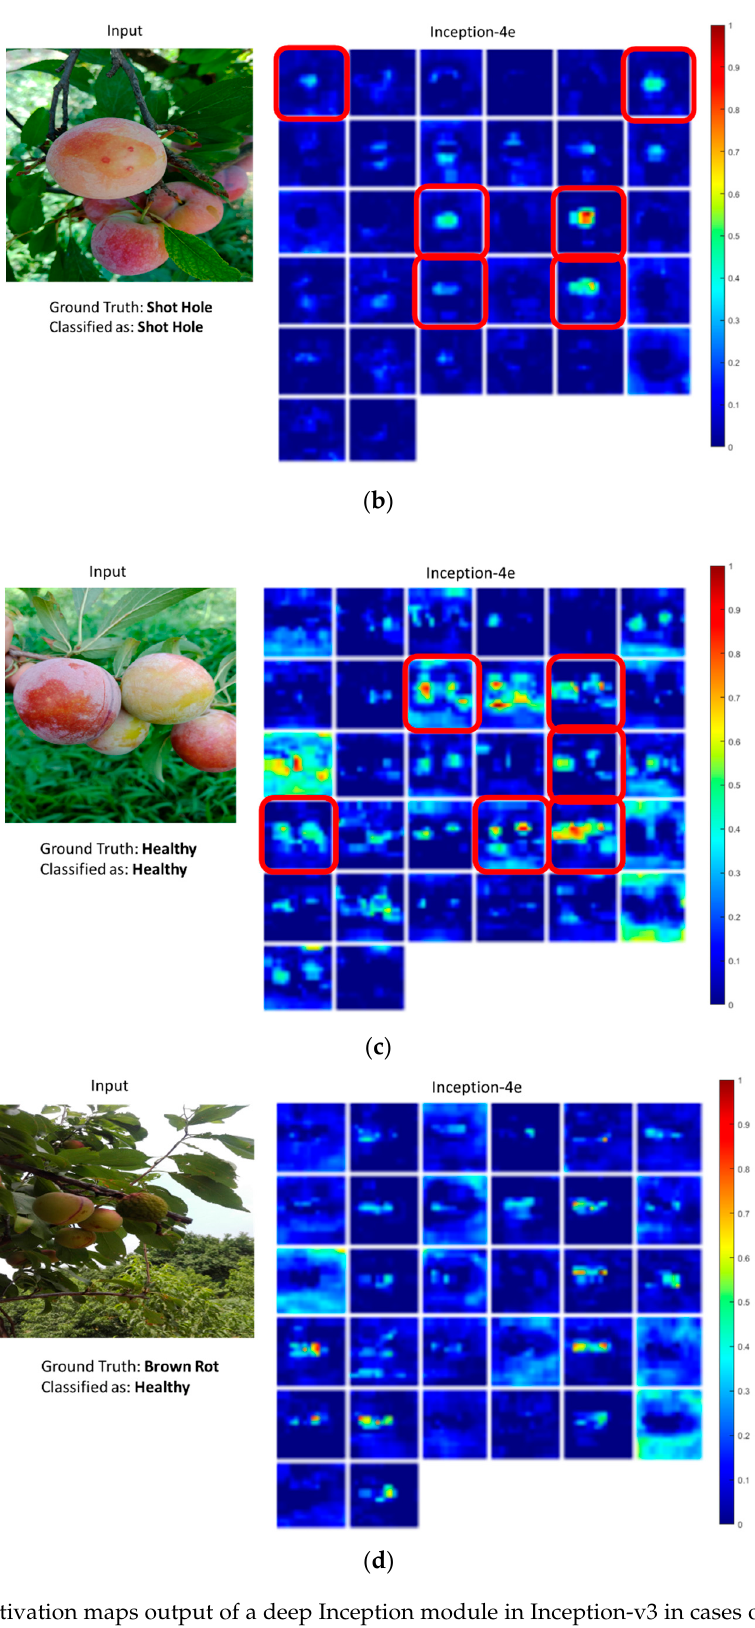
Figure 9. Activation maps output of a deep Inception module in Inception-v3 in cases of ( a ) brown rot, ( b ) shot hole, ( c ) healthy, and ( d ) brown rot. The sample in ( d ) has been incorrectly labeled as healthy. The red boxes indicate neurons with a higher sensitivity to affected fruit even in the presence of healthy fruit.